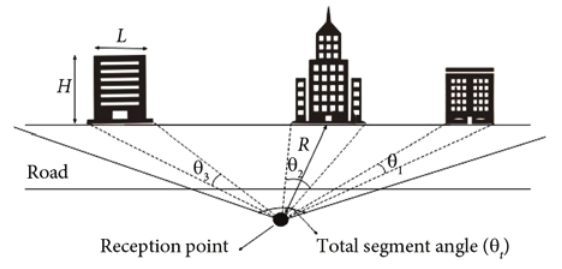
Figure 7. Calculating density and average height of buildings